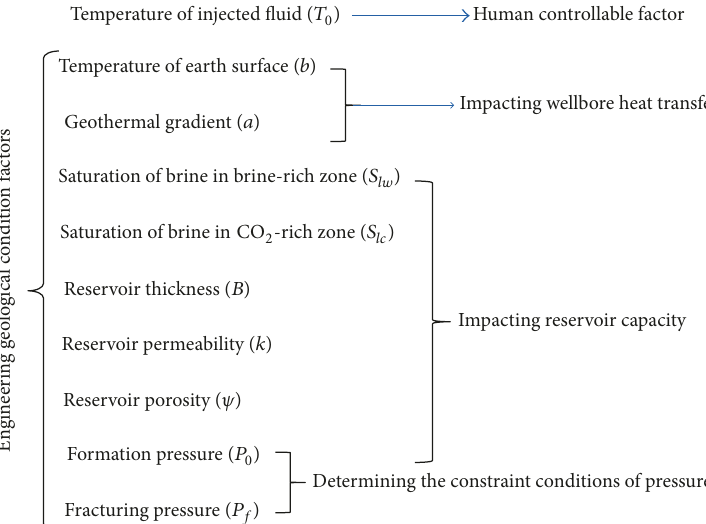
Figure 5: The influential factors of the relationship between wellhead injection pressure and injection rate.